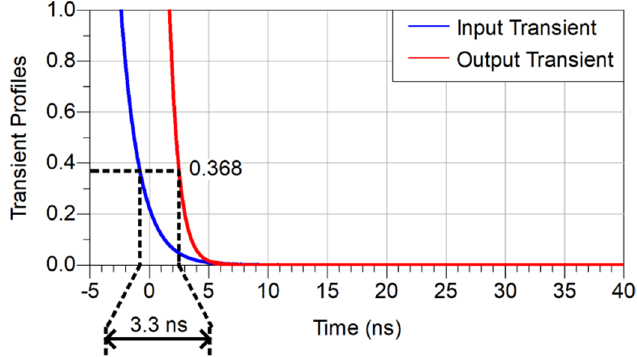
Figure 9. Comparison between the normalized input and output transients and evaluation of the recovery time.